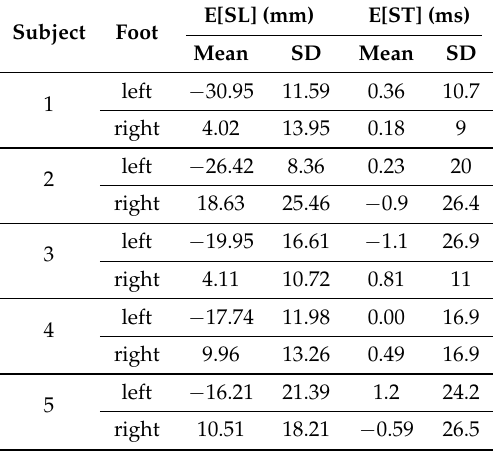
Table 3. Mean and Standard deviation (SD) of error between the gait parameters estimated from proposed and motion capture system at a walking speed of 0.28 m/s. E[SL] and E[ST] represents the error in step length and stride time